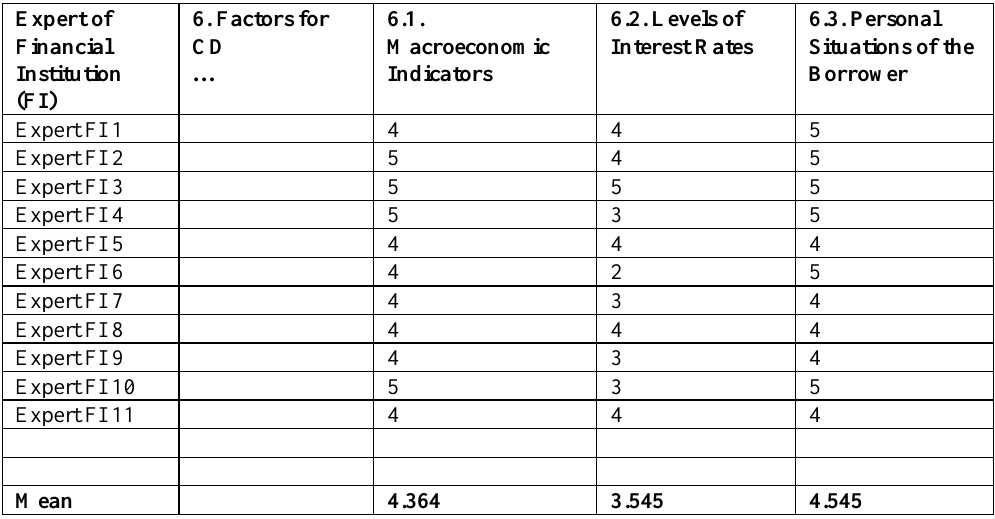
Table 3. The Major Factors for Credit Defaults (developed by the author) Expert